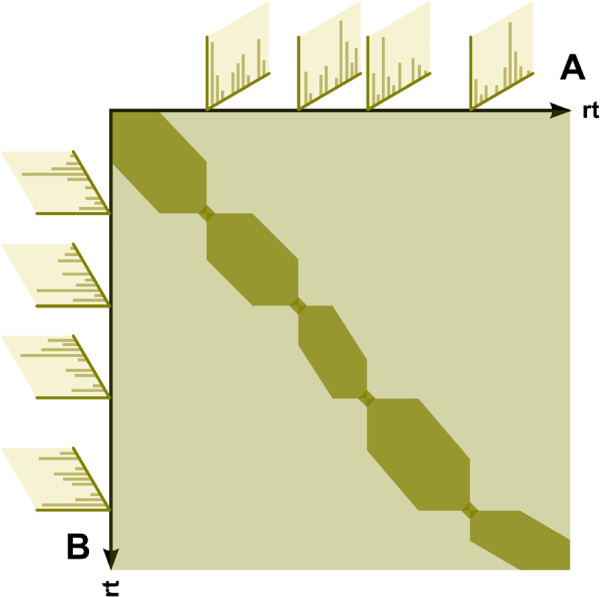
Schematic alignment matrix of partitioned dynamic time warping. Schematic of a pairwise alignment matrix of partitioned dynamic time warping for two arbitrary chromatograms A and B. The light shaded region represents the unconstrained alignment matrix, whereas the dark shaded areas represent the constrained partitions. For every pair of predefined anchors, in this case depicted as mass spectra, a small region around the anchor is kept to allow the alignment a higher degree of flexibility. Each partition is additionally constrained by a local Sakoe-Chiba band constraint. The intersection of all constraint sets
L defines the final layout of the pairwise alignment matrix and thus the number of elements that are compared and stored.